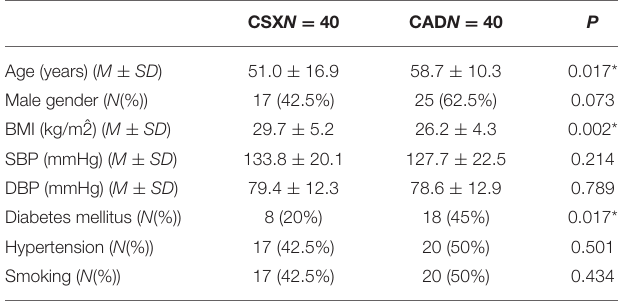
TABLE 1 | Characteristics of the studied CSX and CAD